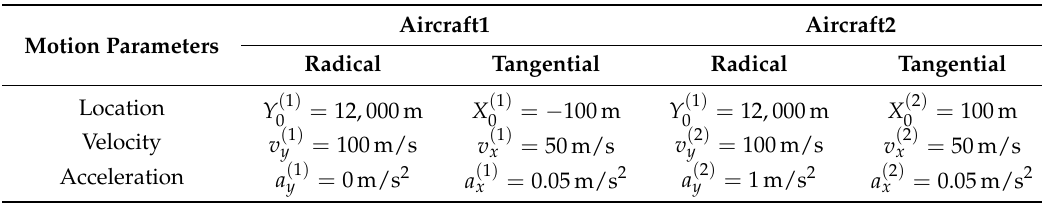
Table 1. The motion parameters of the two-aircraft MAF.